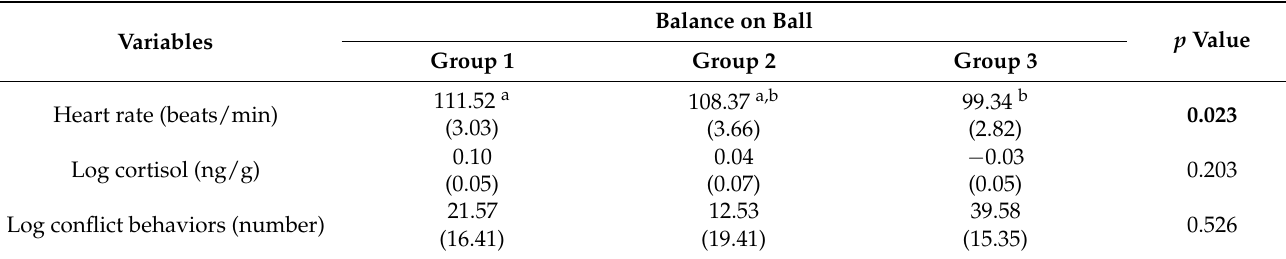
Table 4. Mean value and standard error of the mean for physiological and behavioral variables of the horse according to grade awarded for the rider’s ability to balance on a gymnastic ball (Group 1 = poor, Group 2 = medium, Group 3 = good). Cortisol values are average of samples taken at 0 min and 5 min